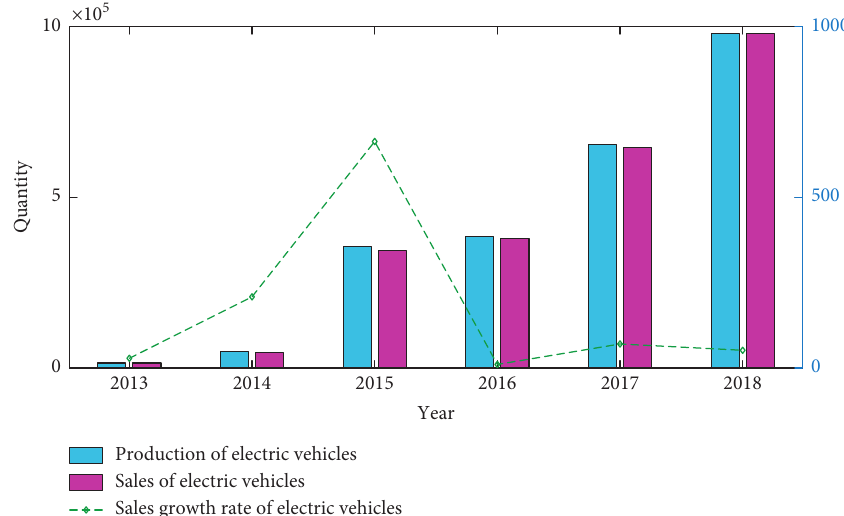
Figure 1: Production and sales of pure electric vehicles from 2013 to 2018.